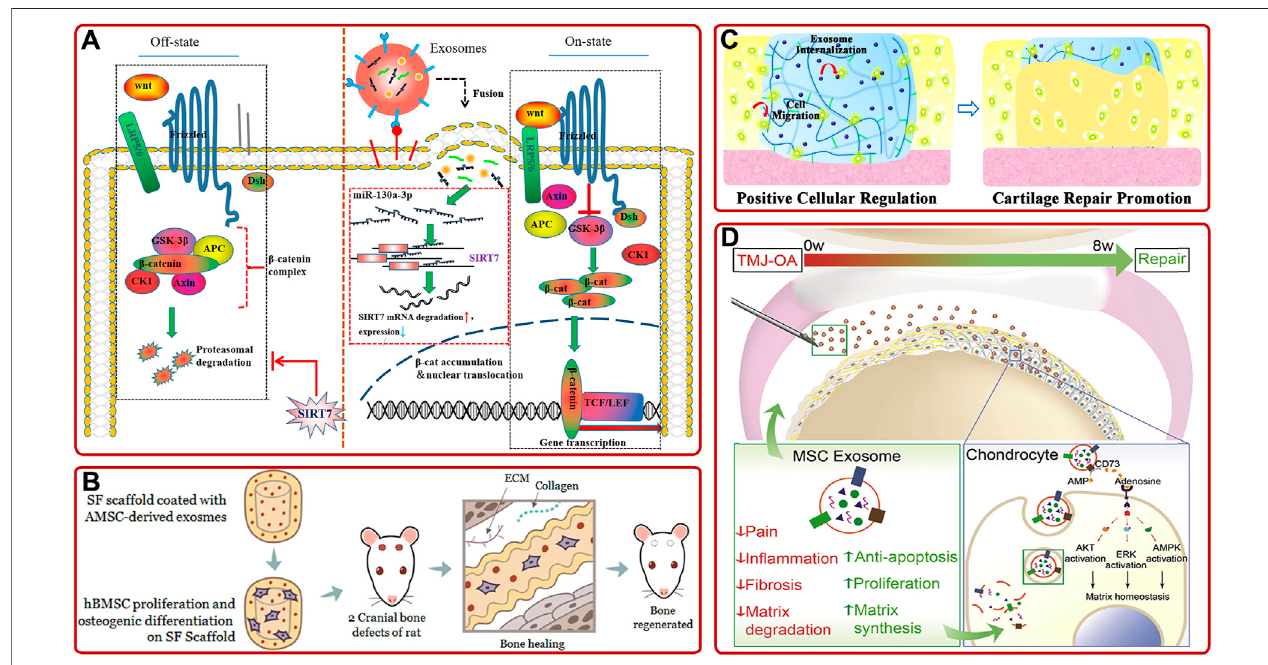
FIGURE 4 | (A) Schematic diagram of the mechanism that AMSC-derived exosomal miR-130a-3p enhanced osteogenic differentiation of AMSCs via the SIRT7/ Wnt/ β -catenin signaling axis (Yang S. et al., 2020). (B) AMSC-derived exosomes-coated silk fi broin 3D-scaffold implants facilitated bone healing in the calvarial bone defects of SD rats (Kyung Kim et al., 2021). (C) IPSC-derived exosomes internalized hydrogel glue positively facilitated cells to promote cartilage repair (Liu et al., 2017). (D) Schematic of the proposed mechanisms of MSC-derived exosome in repairing and regenerating TMJ-OA (Zhang S. et al., 2019).